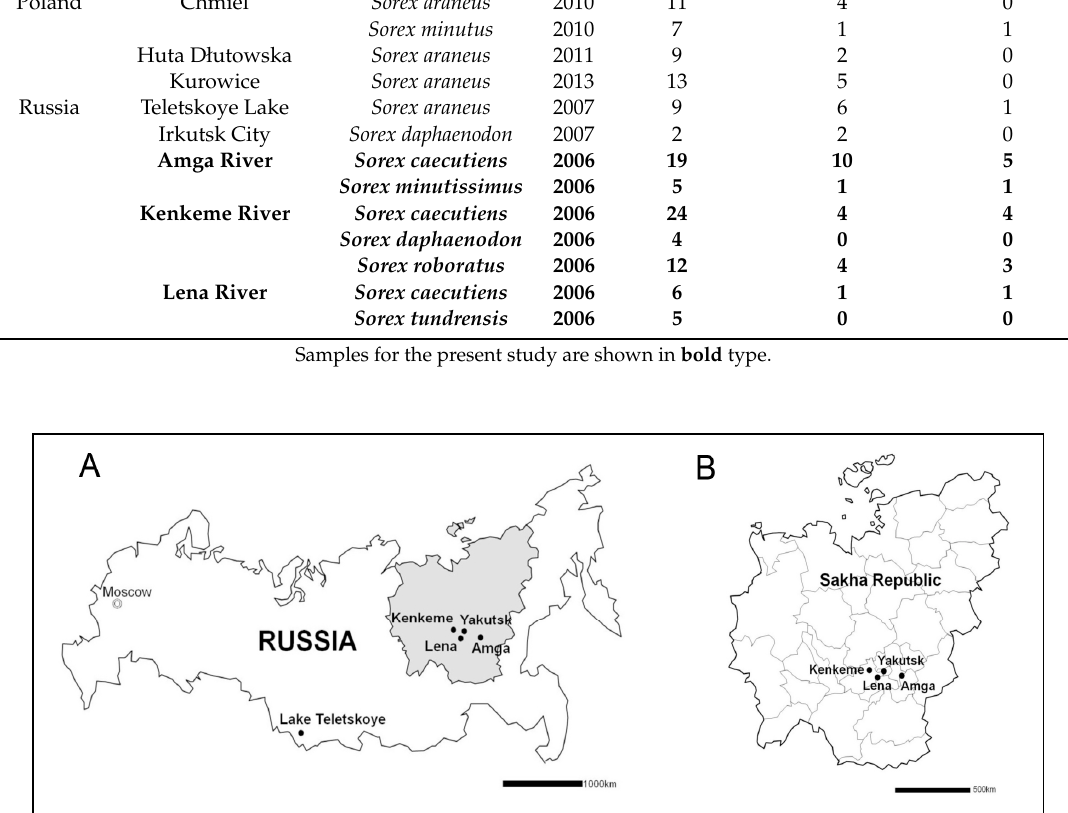
Figure 1. Maps showing ( A ) the location of the Sakha Republic in Far Eastern Russia, and ( B ) the small mammal collection sites in the Sakha Republic, where hantavirus-infected Sorex shrews were captured in July and August 2006.